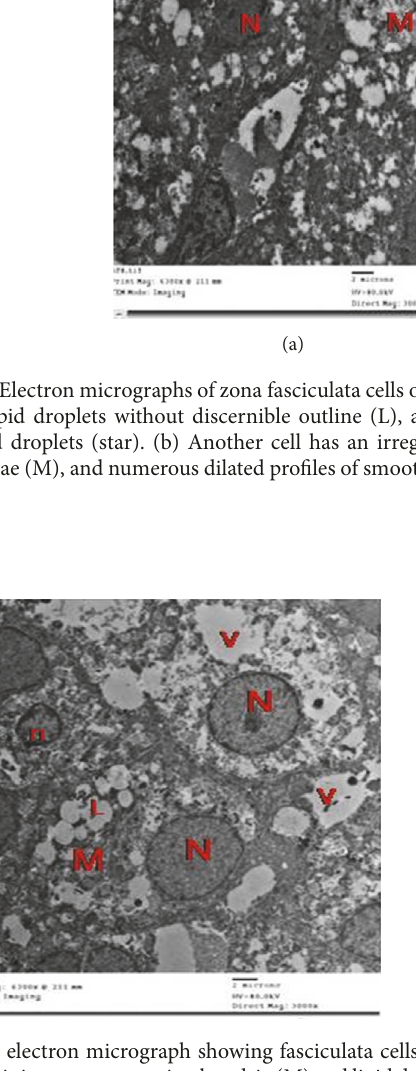
Figure 13: An electron micrograph showing fasciculata cells from group III containing numerous mitochondria (M) and lipid droplets (L). Note large vacuoles (V). Cells have rounded euchromatic nucleus (N) and the other has irregular dense nucleus (n).